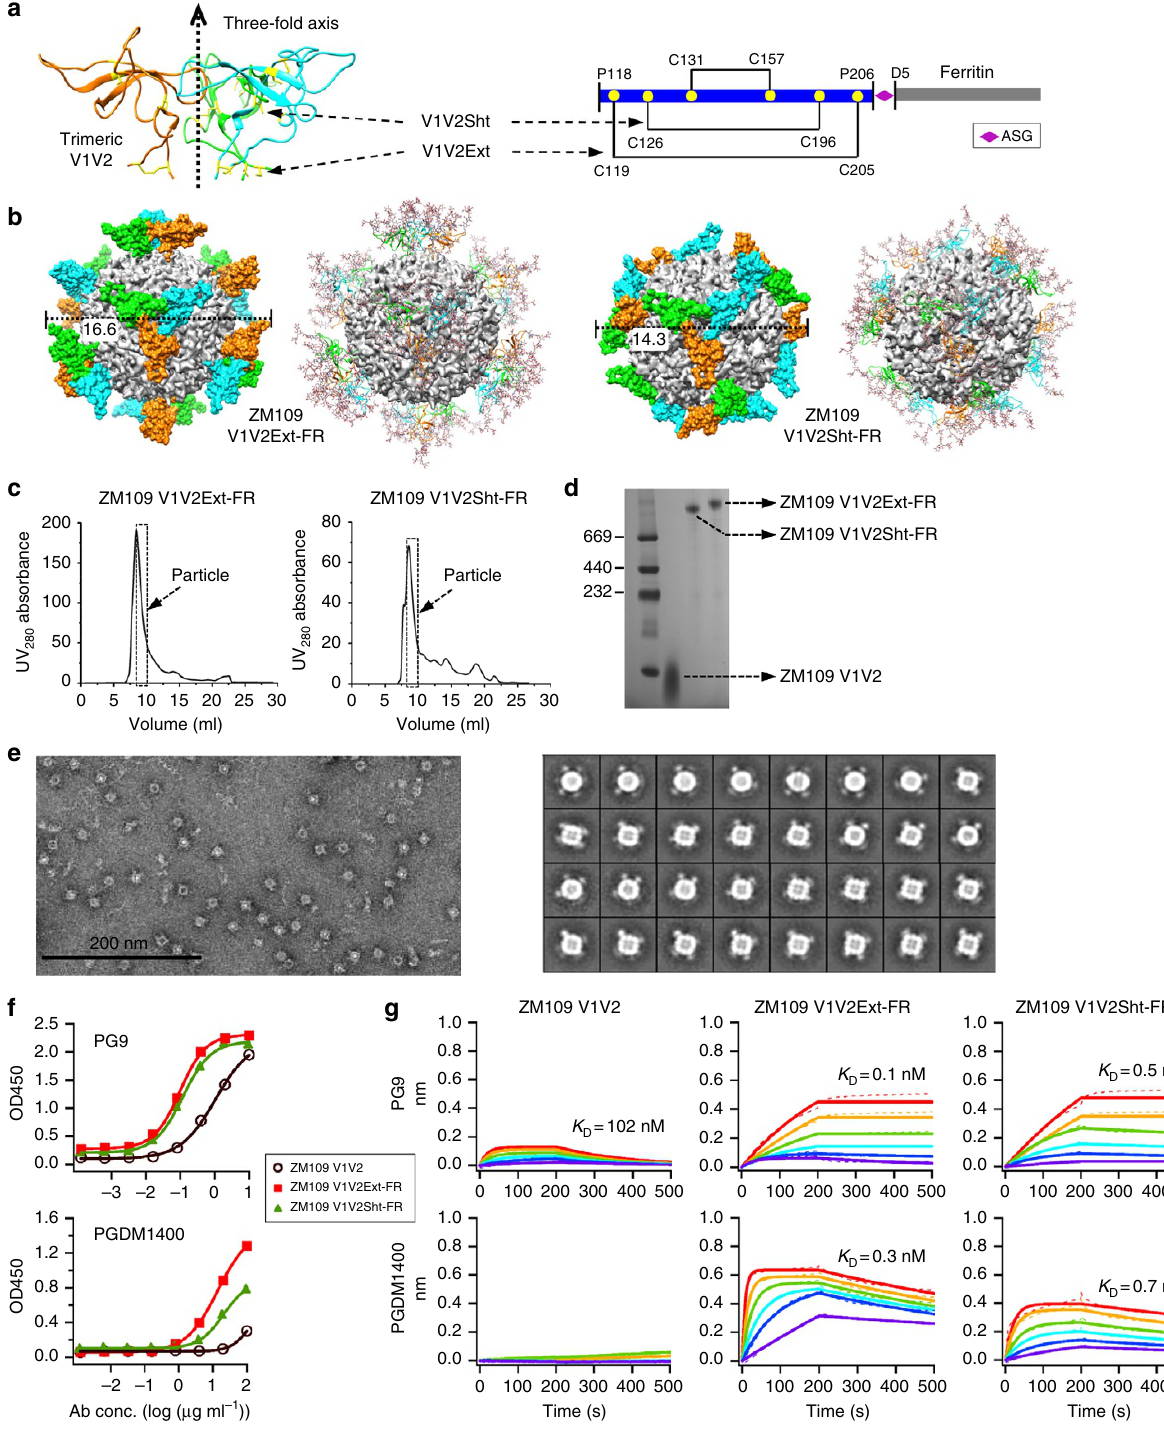
Figure 1 | Design and characterization of V1V2-FR nanoparticles. ( a ) Structure of trimeric V1V2 from clade-C ZM109 modelled on the BG505 SOSIP.664 trimer (PDB ID: 4TVP) (left) and schematic representations of V1V2Sht- and V1V2Ext-FR constructs (right). Three V1V2 chains are coloured in cyan, green and orange, respectively, with the disulfide bonds shown in yellow (side chains in stick model). ( b ) Structural models of V1V2Ext-FR (left) and V1V2Sht-FR (right) nanoparticles. For each design, the surface model of protein particle is shown on the left, whereas the ribbon model of trimeric V1V2 spikes decorated with N -linked glycans is shown on the right. FR and three V1V2 chains within each trimeric spike are coloured in grey, cyan, green and orange, respectively. ( c ) SEC profiles of V1V2Ext-FR (left) and V1V2Sht-FR (right) from a Superdex 200 10/300 GL column. Fractions used for EM and antigenic analyses (8.25–10.0ml) are indicated with a dashed box. ( d ) BN-PAGE of monomeric V1V2 and two V1V2-FR nanoparticles. ( e ) Micrograph (left) and 2D class averages (right) of V1V2Ext-FR derived from negative-stain EM. ( f ) ELISA binding of monomeric V1V2 and two V1V2 nanoparticles to apex-directed bNAbs PG9 and PGDM1400. ( g ) Octet binding of monomeric V1V2 and two V1V2-FR nanoparticles to PG9 and PGDM1400. Sensorgrams were obtained from an Octet RED96 instrument using a titration series of six starting at the maximum of 500nM for monomeric V1V2 and 50nM for V1V2 nanoparticles, respectively. K D values are calculated from 1:1 global fitting for apex-directed bNAbs PG9 and